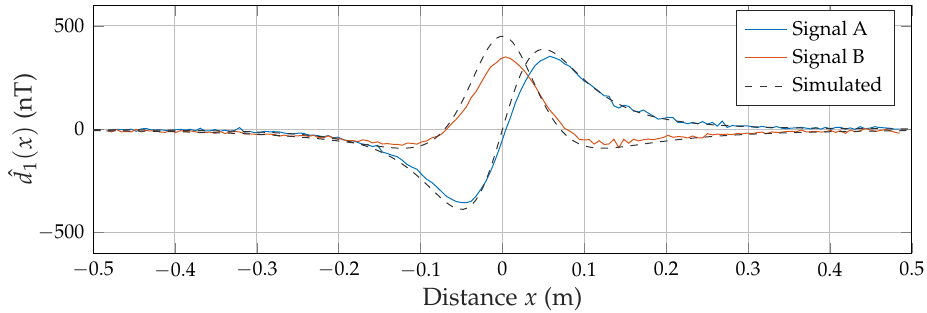
Figure 11. Estimated desired signals in an FDMA